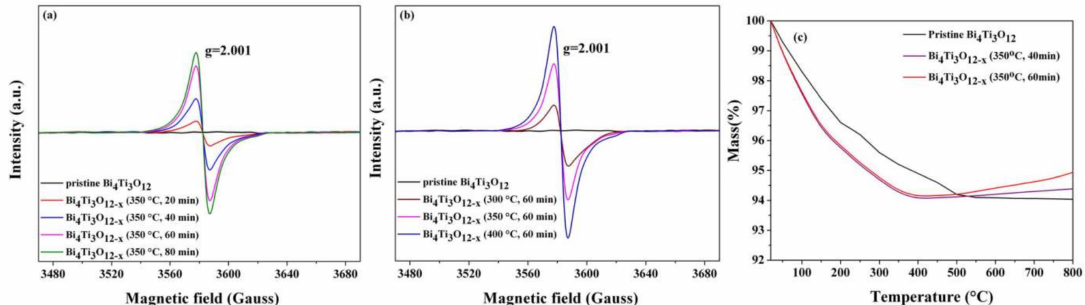
Figure 6. ( a ) electron paramagnetic resonance (EPR) spectra of pristine Bi 4 Ti 3 O 12 and Bi 4 Ti 3 O 12 − x after chemical reduction treatment ( a ) at 350 ◦ C for different times; ( b ) at different temperatures for 60 min; and ( c ) thermogravimetric analysis (TGA) curves of the pristine Bi 4 Ti 3 O 12 , Bi 4 Ti 3 O 12 − x (350 ◦ C, 40 min), and Bi 4 Ti 3 O 12 − x (350 ◦ C, 60